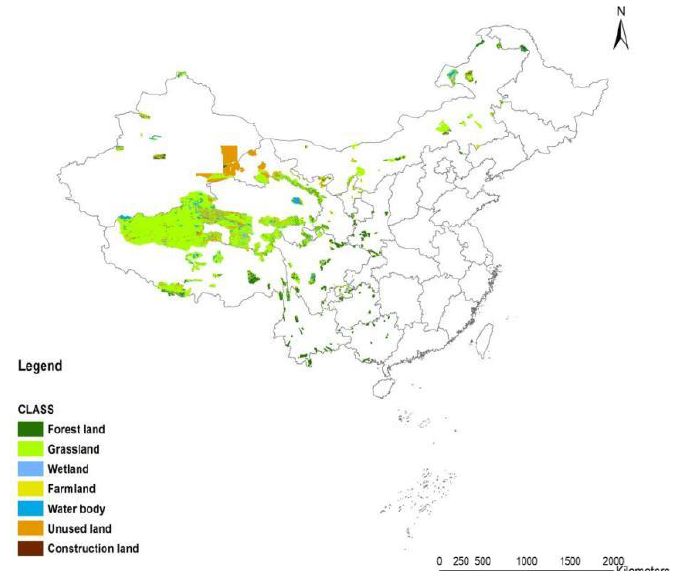
Figure 2. Land use in the national nature reserves of western China in 2000.